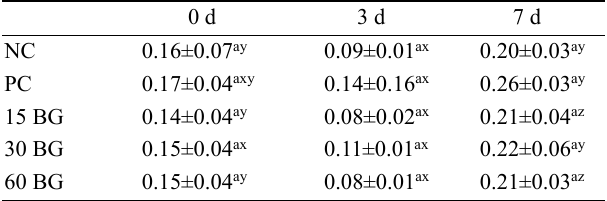
Table 6. Dietary effects of β-glucan on the lipid oxidation in raw broiler chicken breast meat